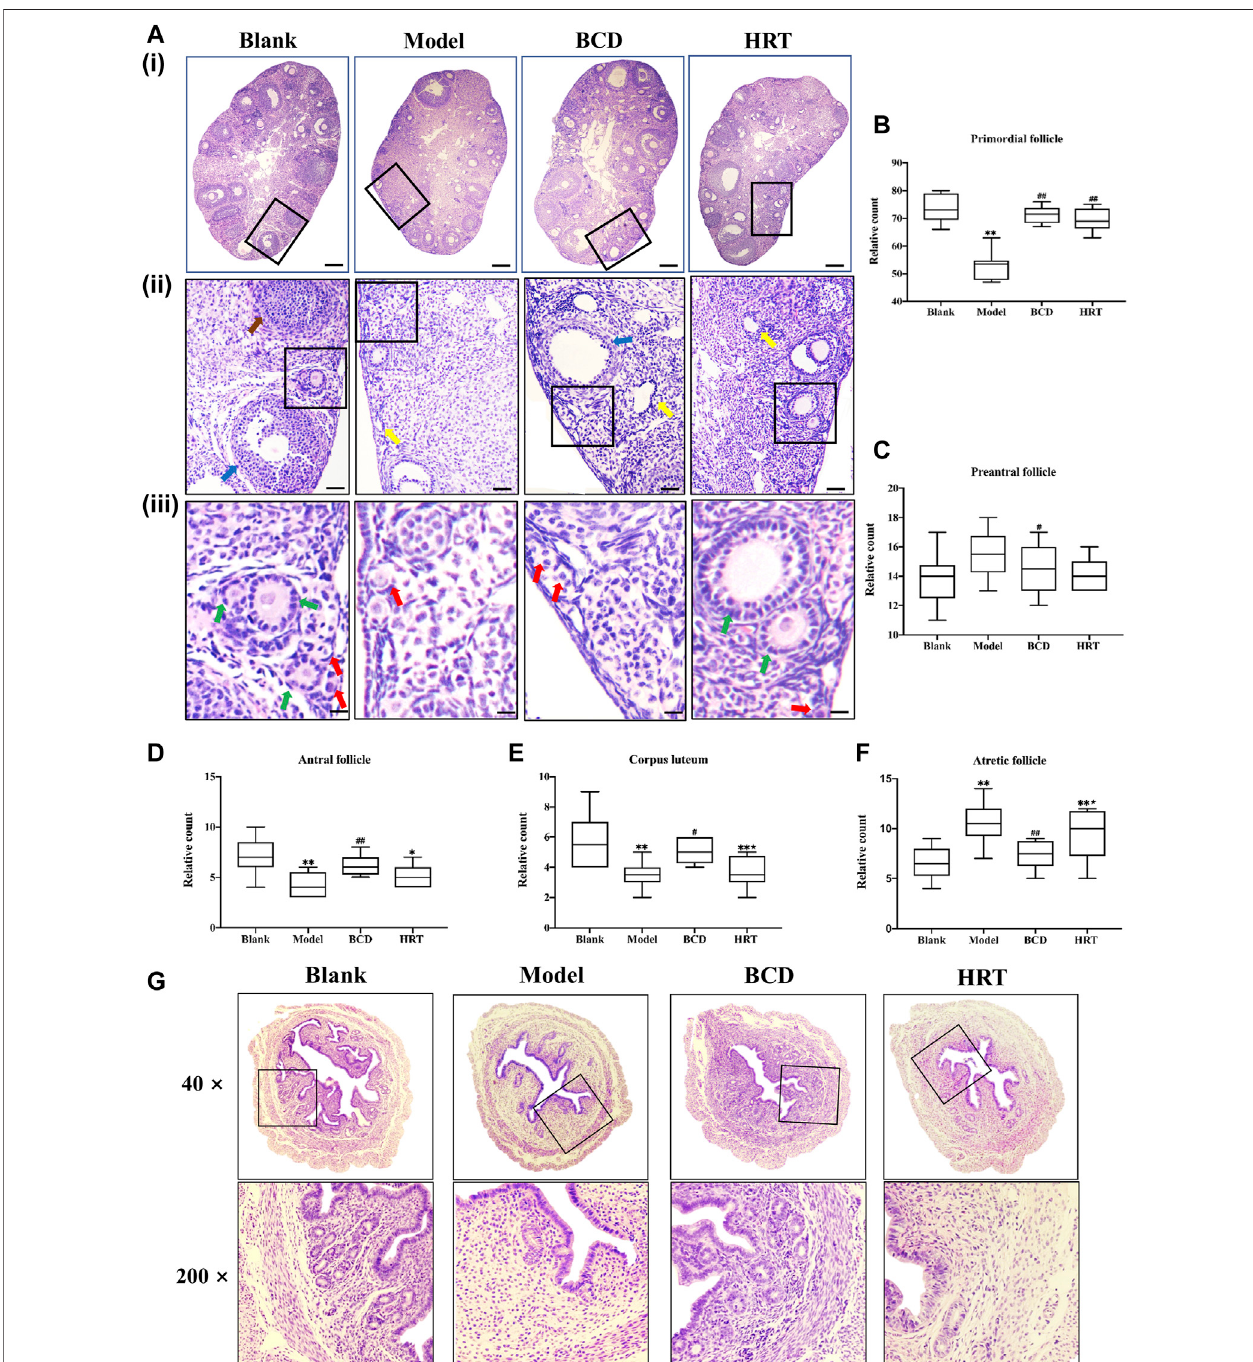
FIGURE4 | BCD protects the ovarian reserve and uterus ofTWP-induced POImice. (A) HE-stained ovarian sections and their representative images are depicted (×40,×100×,and×400magni fi cation).Theredarrowshowsprimordialfollicles,thegreenarrowshowspreantralfollicles,thebluearrowshowsantralfollicles,theyellow arrowshowsatreticfollicles,andthebrownarrowshowsacorpusluteum.Thescalebarsrepresent200 μ m (i) ,50 μ m (ii) and25 μ m (iii) .Imageanalysesincluded three serial sections per mouse, which were then evaluated for the total primordial (B) , preantral (C) , antral (D) , corpus luteum (E) , and atretic (F) . (G) HE-stained uterine sectionsandtheirrepresentativeimagesaredepicted(×40,×200magni fi cation).Dataisvisualizedintermsofmeans±SEM.( n =8,* p < 0.05,** p < 0.01,comparedwith the Blank group; # p < 0.05, ## p < 0.01, compared with the Model group; + p < 0.05, ++ p < 0.01, compared with the BCD group).